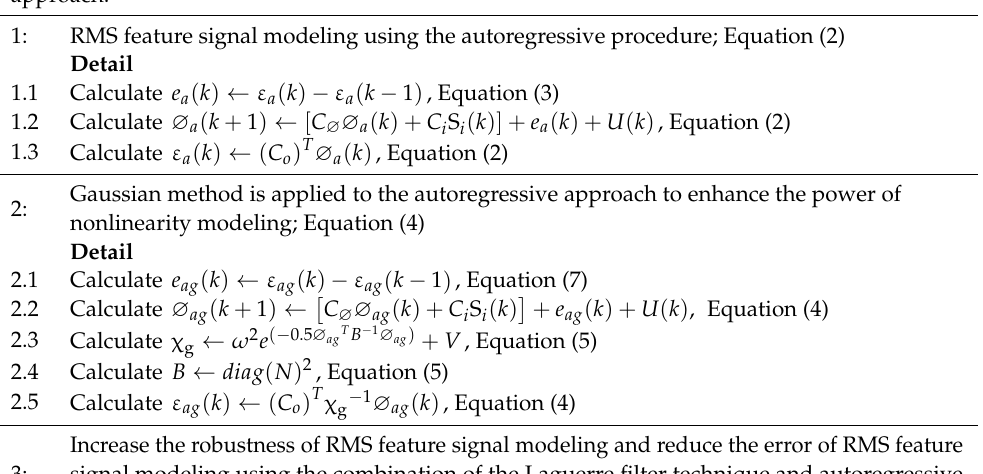
Algorithm 1: Proposed RMS feature modeling using the autoregressive fuzzy Gauss–Laguerre